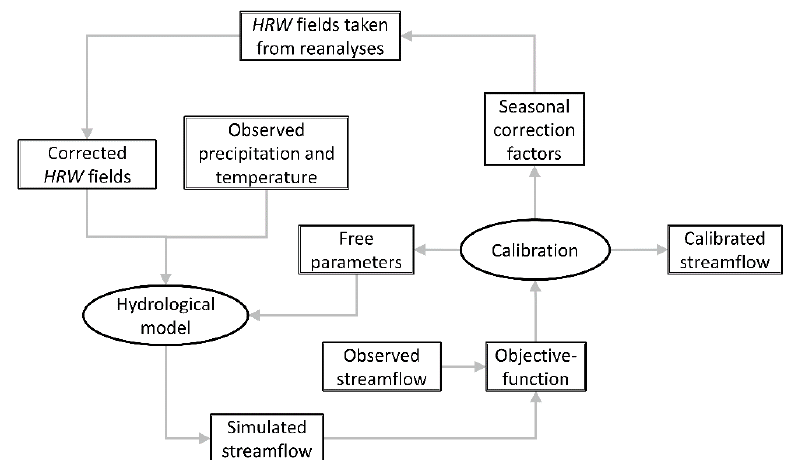
Figure 2. Calibration-based correction of HRW fields taken from reanalyses. Seasonal correction factors are calibrated concomitantly to the hydrologic model according to an objective-function, the latter minimizes deviation between observed and simulated streamflow.